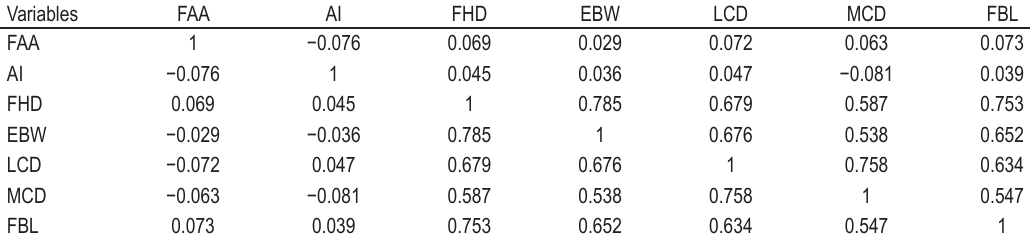
TABLE 3. Correlation matrix for both samples